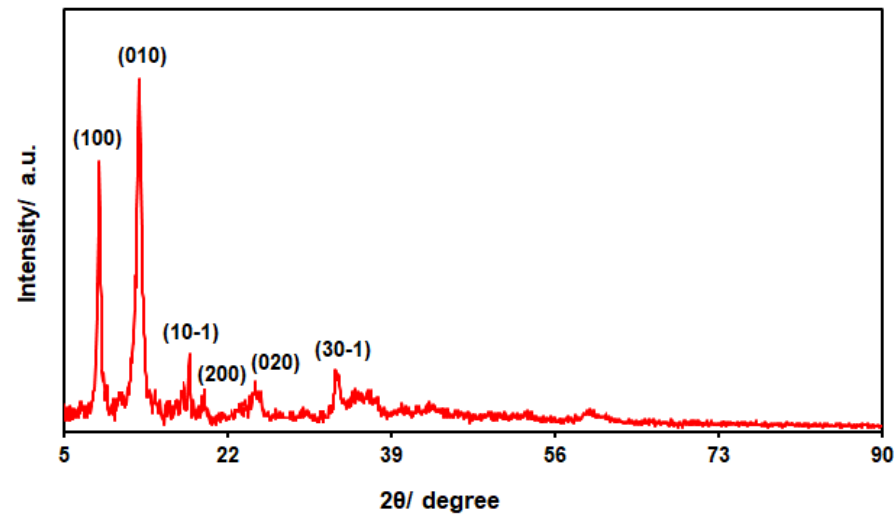
Figure 3. XRD pattern captured for as-fabricated bimetallic NiCo-MOF nanosheets.